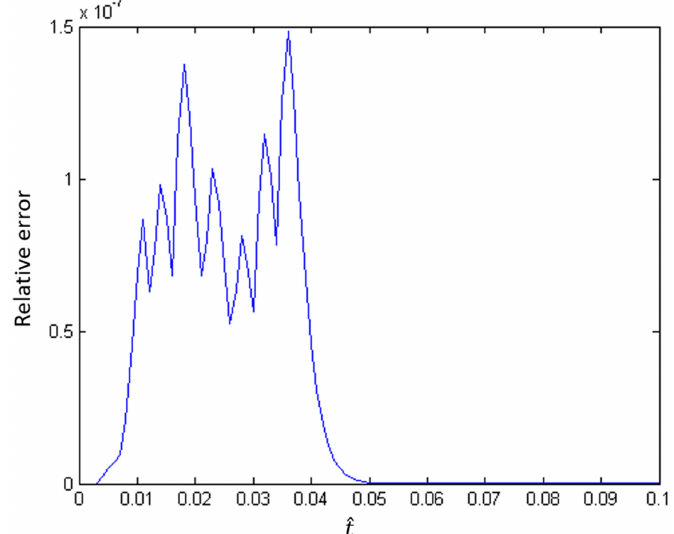
Figure 7. Error propagation of hybrid splitting method with many iterations for linear material